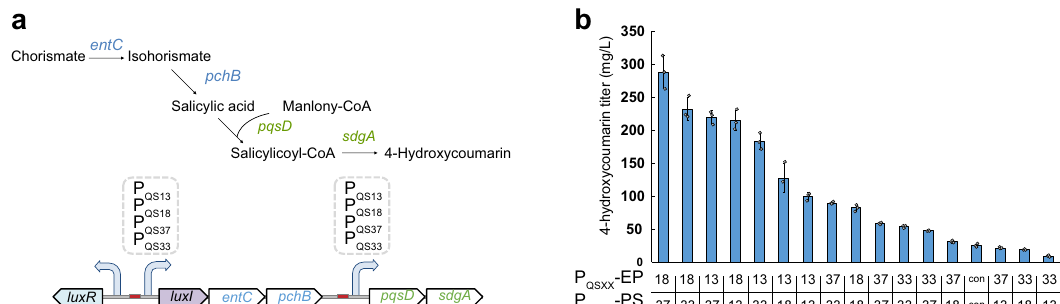
Fig. 5 Application of QS variants for dynamic modular optimization of 4-HC production. a Schematic of construction of dynamic control circuits for regulation of 4-HC biosynthetic pathway. b The effect of different triggering OD of QS variants individually driving entC-pchB expression and pqsD-sdgA expression on 4-HC titer. Con represents 4-HC titer generated by the control strain expressing EP and PS modules on constitutive promoters. Gene: entC encodes isochorismate synthase, pchB encodes isochorismate pyruvate lyase, pqsD encodes CoA ligase, sdgA encodes biphenyl synthases. Data shown are mean ± SD ( n = 3 independent experiments). Source data are provided as a Source Data